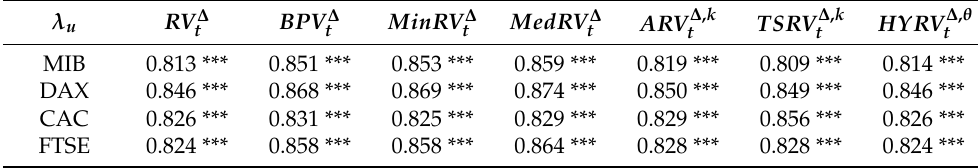
Table 6. Upper tail dependence coefficients from the Gumbel